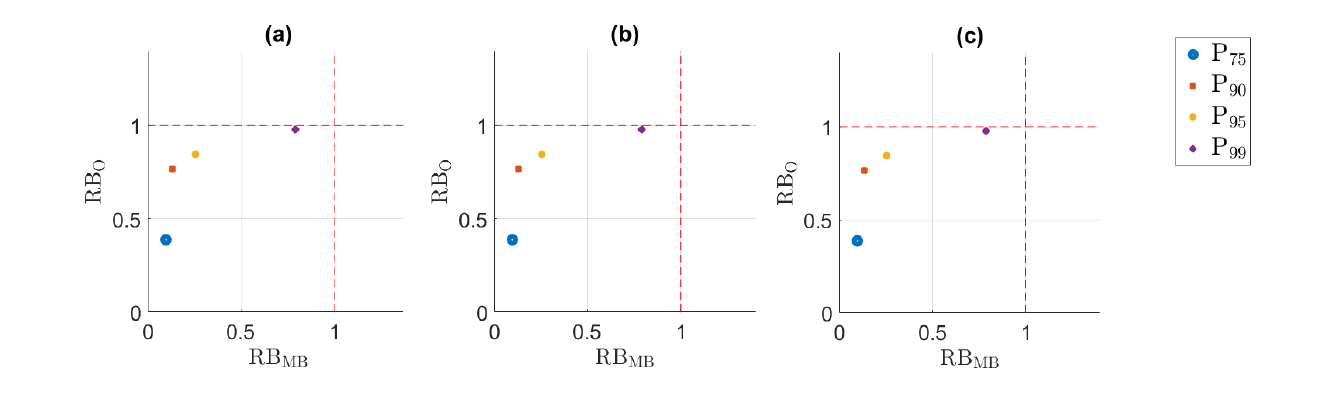
Figure 3. RB MB versus RB O for the precipitation intensity percentiles. ( a ) QDM, ( b ) SSR & QDM, ( c ) TDA &